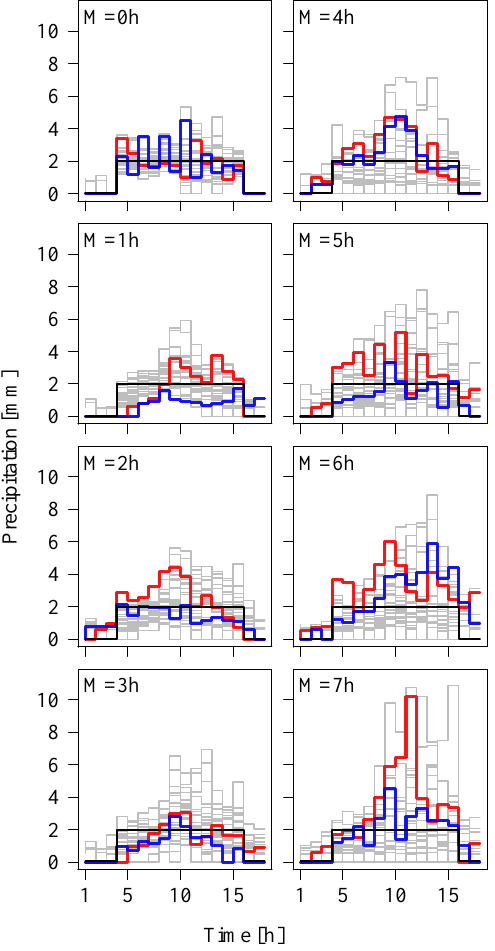
Fig. 9. Sensitivity analysis. Precipitation ensemble (24 realisations in grey, from which two realisations are shown in red and blue) for eight types of simulation scenarios given a simulation memory M of 0–7h, for a pixel located in the centre of the simulation domain. Black line stands for the synthetic rain gauge observation. Rainfall scenario for the advection speed of 6kmh − 1 (see Fig.